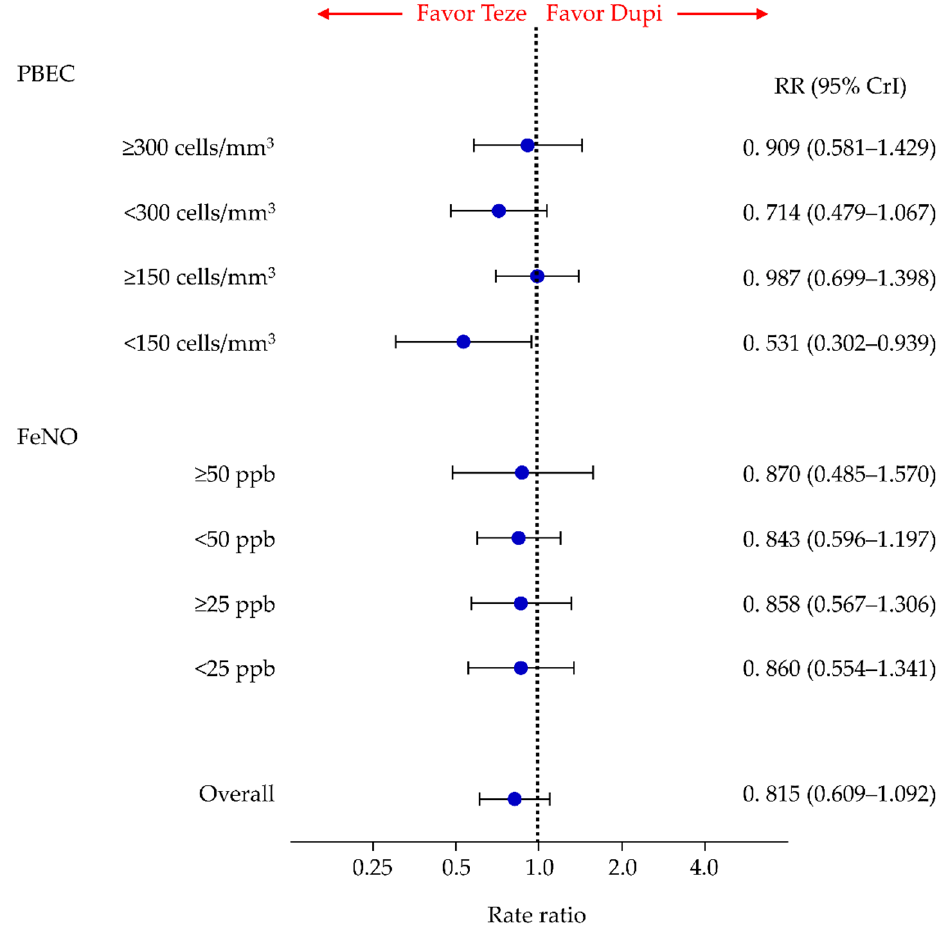
Figure 4. Comparative efficacy of tezepelumab and dupilumab in terms of AERs in patients with inadequately controlled asthma for all participants and subgroups stratified by threshold levels of PBEC and FeNO. Comparisons are expressed as tezepelumab versus dupilumab. Data are expressed as rate ratios (RRs) and 95% credible intervals (CrIs). AER, annualized exacerbation rate; Teze, tezepelumab; Dupi, dupilumab; PBEC, peripheral blood eosinophil counts; FeNO, fractional exhaled nitric oxide.